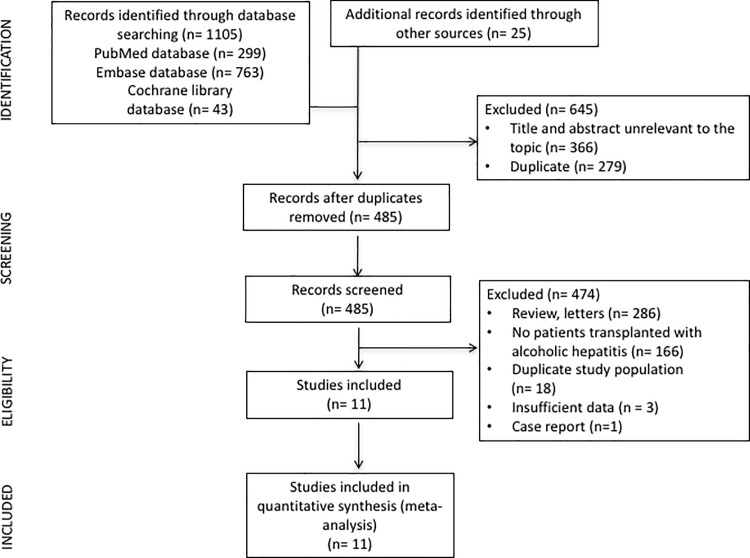
Flow chart of the selection of studies for inclusion in the meta-analysis.